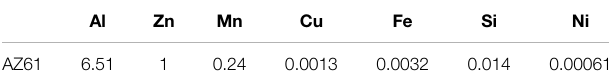
TABLE 1 | Compositions (wt%) of AZ61 in this